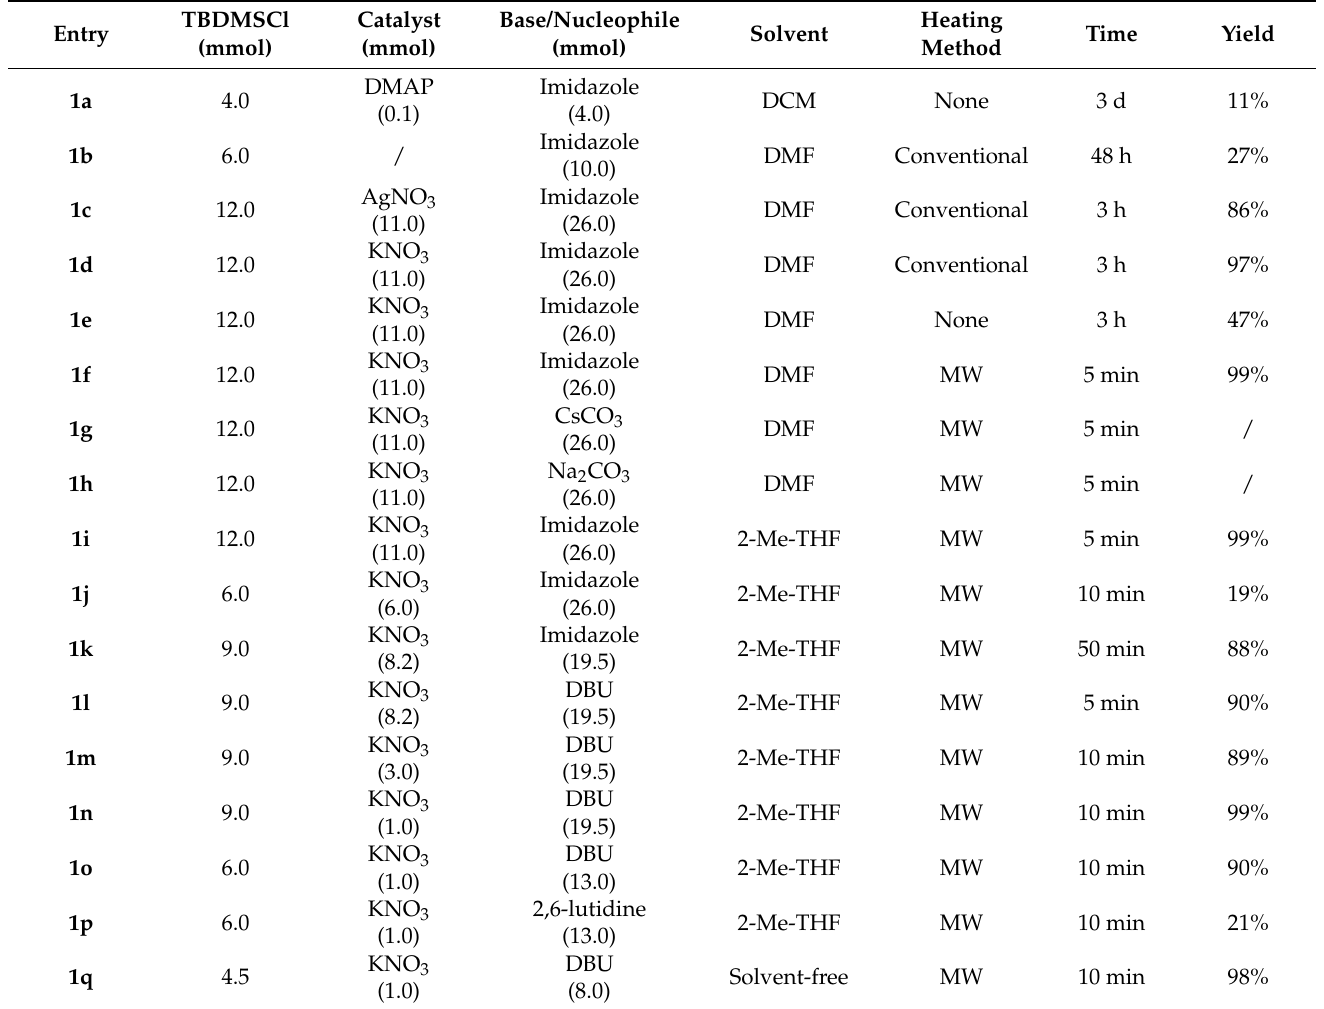
Table 1. O -silylation of uridine with TBDMSCl using different catalysts, solvent bases and reaction